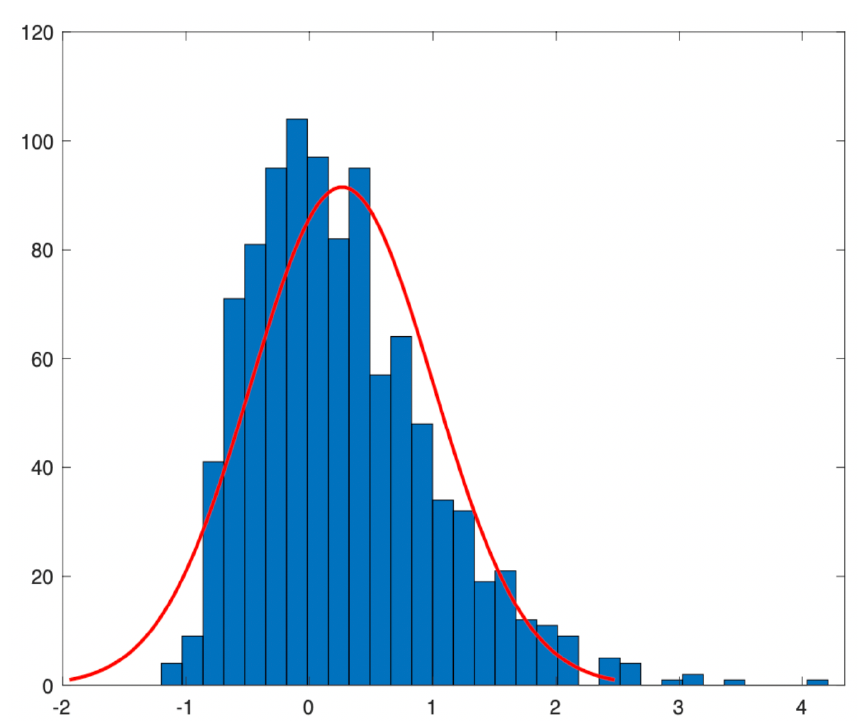
Figure 2. asymptotical normality of ˆ β T − β when β = 0.2, H = 2/3, and T =